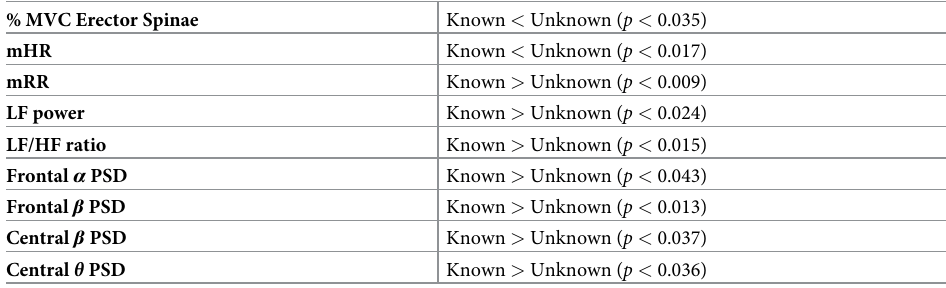
Table 5. Summary of significant contrasts where the main effects of the weight knowledge was significant. % MVC Erector